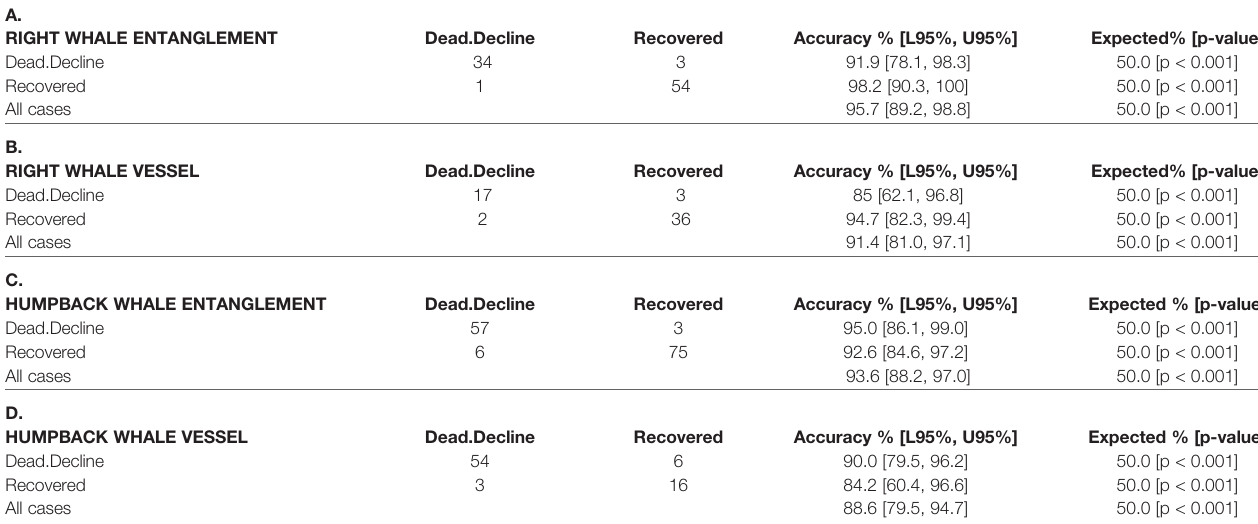
TABLE 3 | A – D Confusion matrices for entanglement and vessel strike models from known outcome health status cases of right and humpback